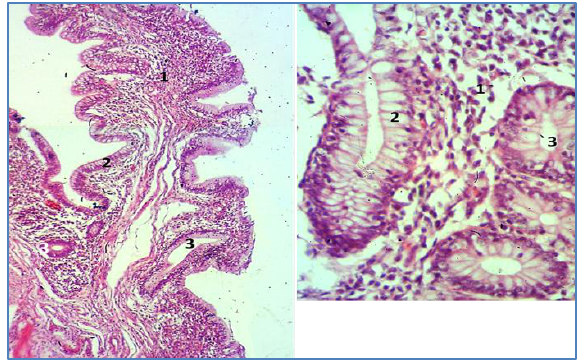
Figure, 6: magnified sections of urodeum villus (hen turkey) shows: lamina propria (1), mucous secreting epithelium (2) and epithelial tubular glands (3), (H and E) satin. 100x and 400x.